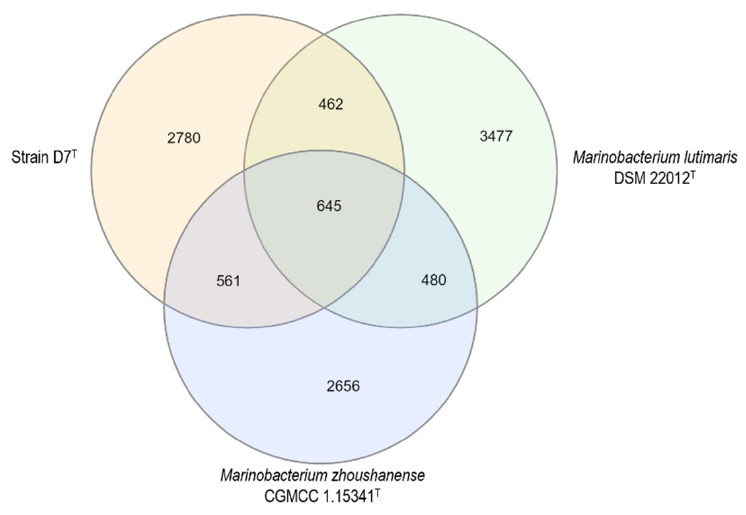
Figure 2. Venn diagram showing the number of genes shared between the genome of strain D7 T ,